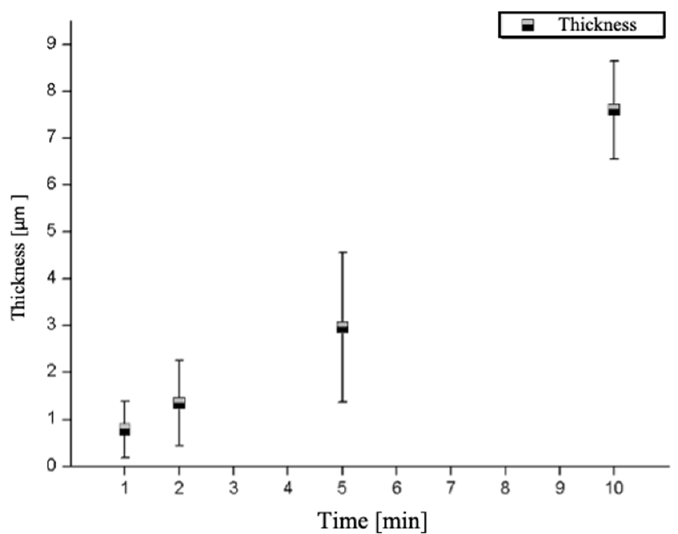
Figure 5. Coatings average thickness ( μ m) according to deposition time.